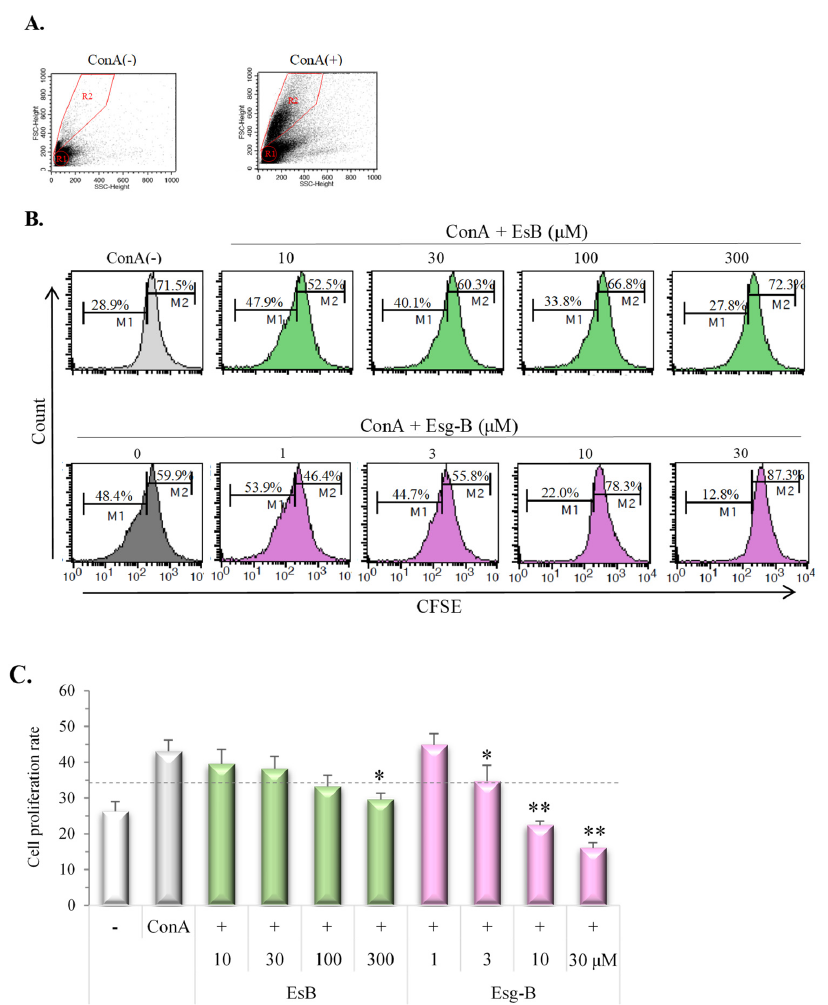
Figure 4. EsB/Esg-B inhibition of ConA blast proliferation tracing by CFSE. ( A ) Cell division in CFSE-labeled splenocytes was determined by flow cytometric analysis. Splenocytes were labeled with CFSE and treated with 0.1% DMSO, or the respective concentrations of EsB/Esg-B for 1 h, then stimulated with ConA (1 μ g/mL) for 72 h. Alterations in light scatter characteristics: splenocytes alone (left), ConA blast of splenocytes (right). All plots were gated on CD3-positive cells including both resting lymphocytes (R1) and blasts (R2). ( B ) Representative histogram plots show the cell division associated with CFSE-labeled splenocytes without and with EsB/Esg-B, while the histograms were gated to both R1 and R2. ( C ) Expression of cell division percentage (M1) by ConA blast without and with EsB/Esg-B addition. Data represent five independent experiments, and each bar is expressed as mean ± SEM. *: p < 0.05, **: p < 0.01, significantly different from the Control (ConA alone). EsB: Esculeoside B; Esg-B: Esculeogenin B. The grey dotted line shows about 50% of ConA-induced elevated